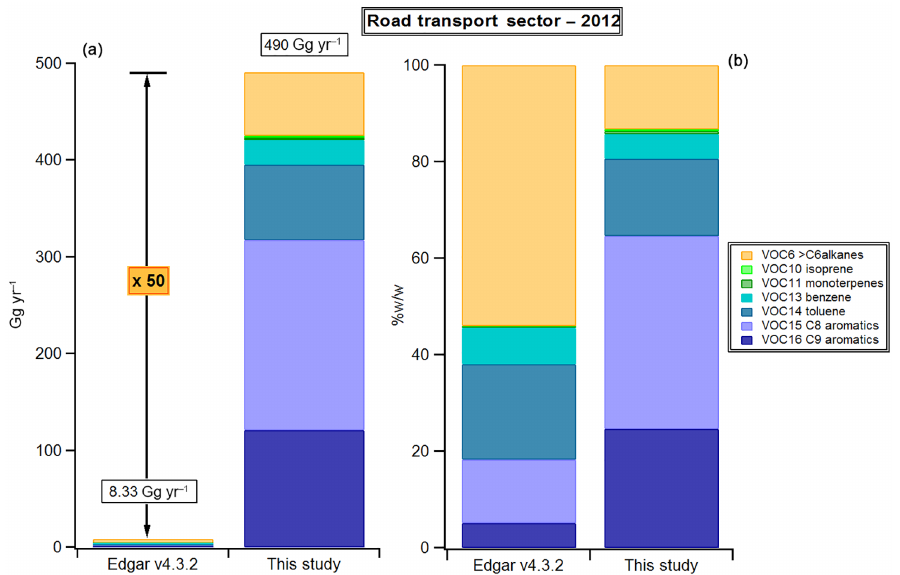
Figure 6. Comparison of Côte d’Ivoire VOC emissions with the Edgar v4.3.2 inventory (Huang et al., 2017) for the road transport sector in 2012: (a) absolute emissions in Ggyr − 1 and (b) relative mass emissions for selected VOC groups.